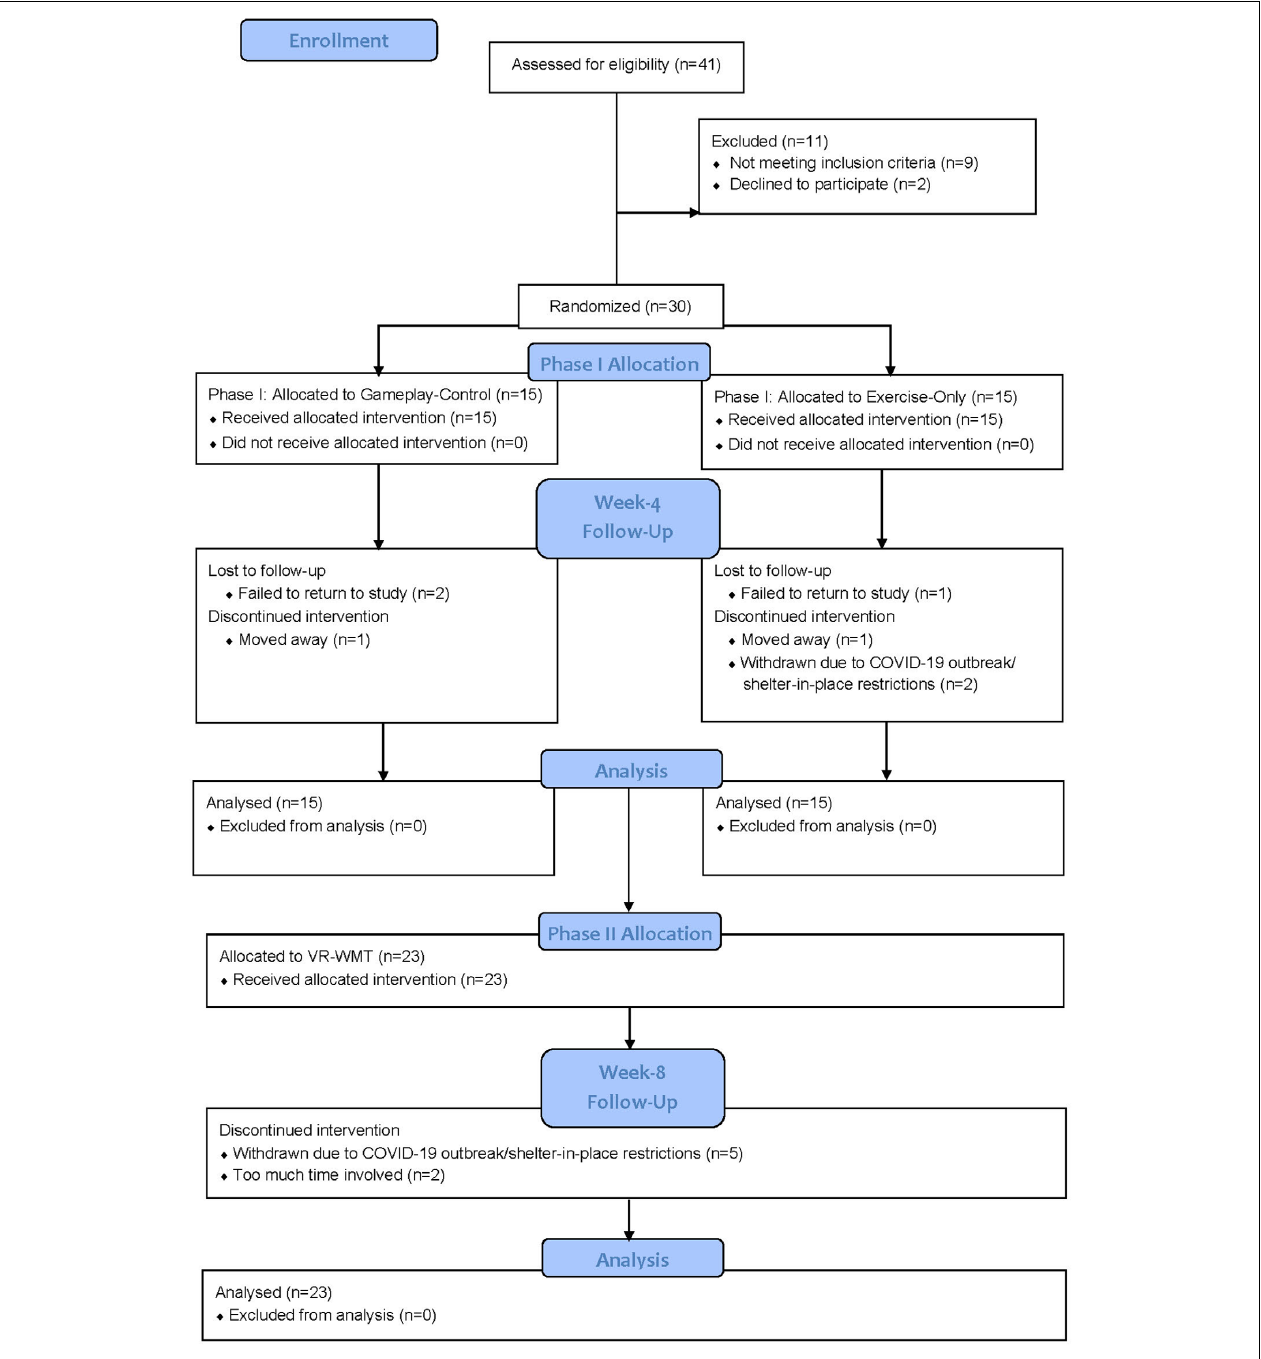
FIGURE 2 | Consort flow